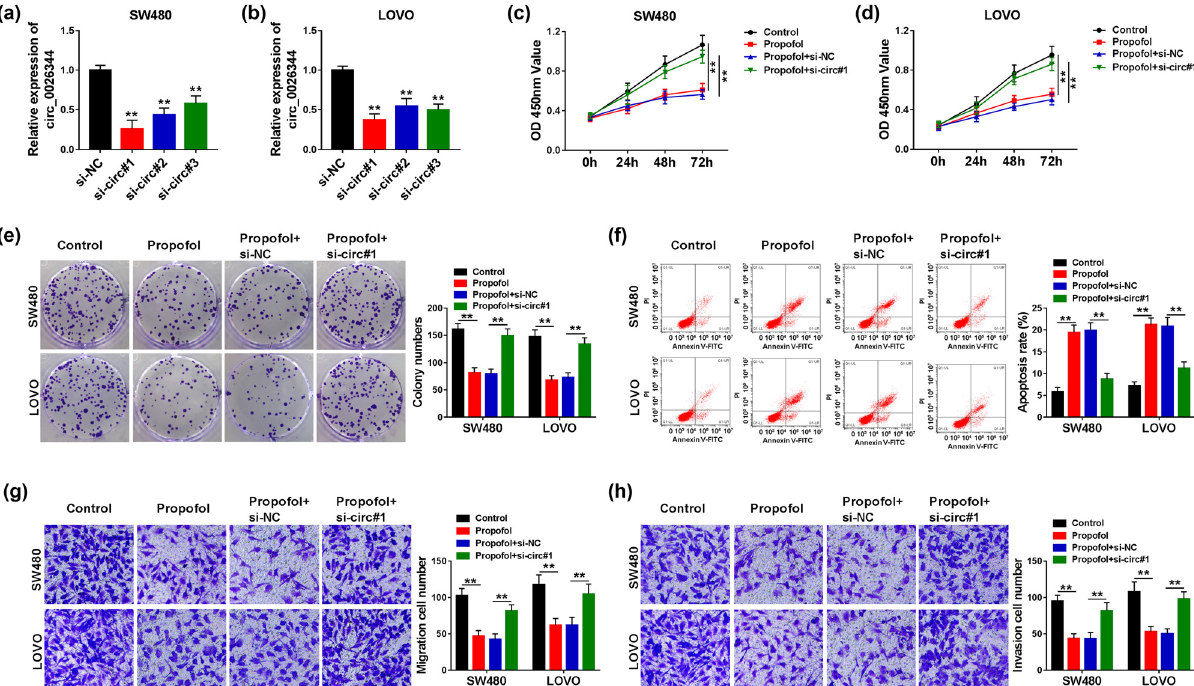
Figure 3: circ_0026344 silencing attenuated propofol - mediated e ff ects on CRC progression. ( a and b ) The interfering e ffi ciency of si - circ#1, si - circ#2, and si - circ#3 was determined by qPCR in SW480 and LOVO cells. ( c – e ) The impacts between propofol treatment and circ_0026344 silencing on cell proliferation were explained by CCK8 and colony formation assays. ( f ) The in fl uences between propofol treatment and circ_0026344 knockdown on the apoptosis of SW480 and LOVO cells were presented by fl ow cytometry analysis. ( g and h ) The in fl uences between propofol treatment and circ_0026344 absence on the migration and invasion of SW480 and LOVO cells were revealed by transwell assay. Signi fi cant di ff erences were compared with ANOVA. ** P < 0.01.